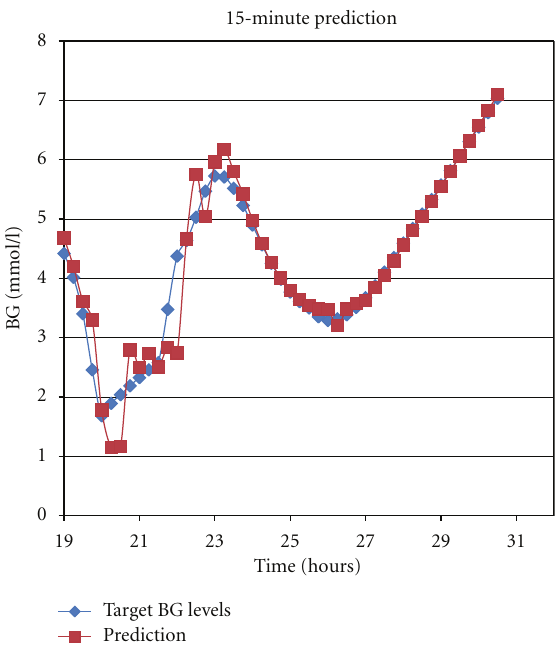
Figure 5: 30-minute prediction results from a day of data not used during AIDA training.